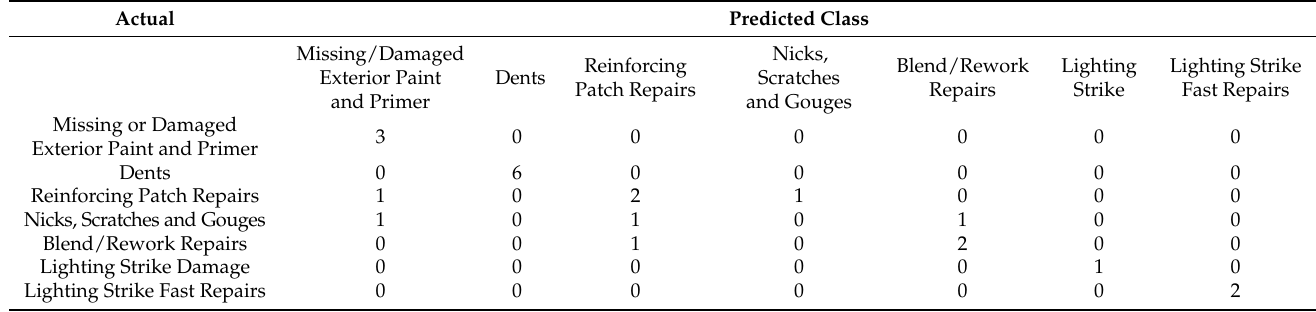
Table 12. Confusion matrix of